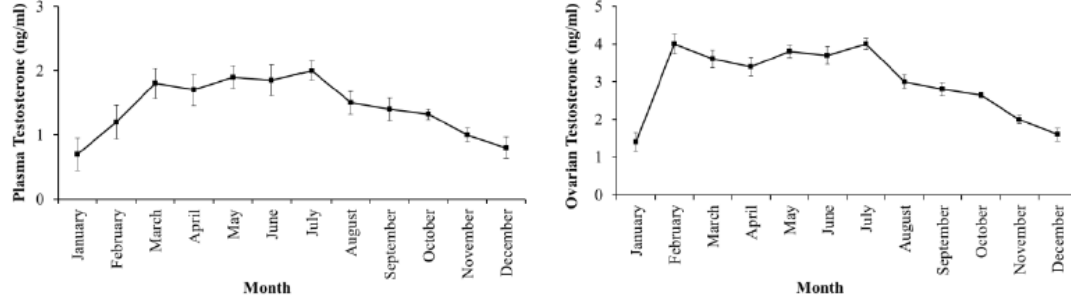
Figure 7. Monthly change in testosterone levels in plasma ( left ) and ovaries ( right ) of the wild-caught blue tang fish (n the same as Figure 2a).